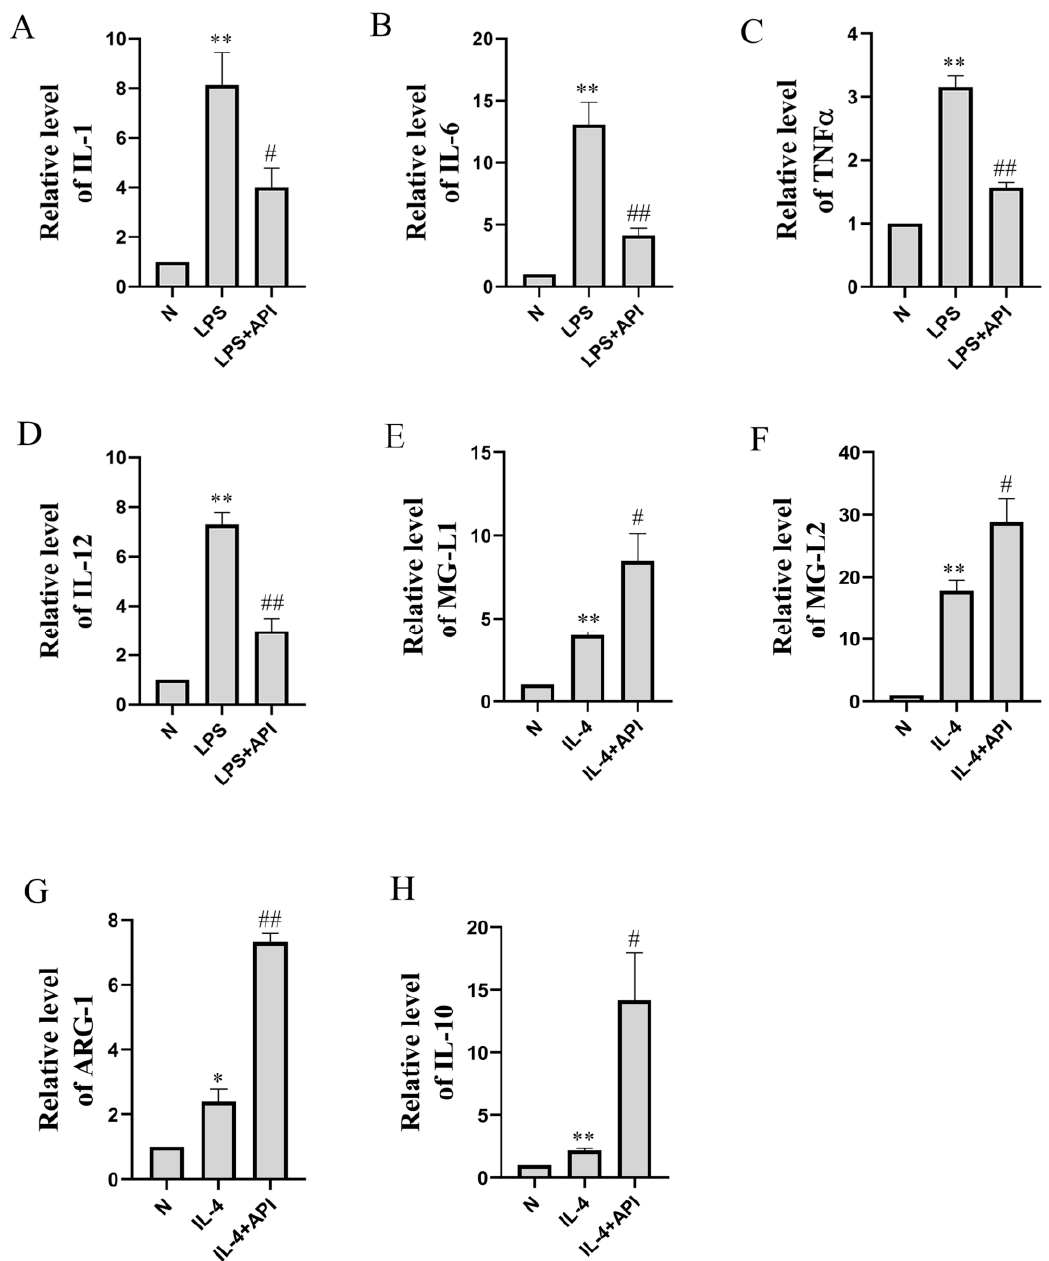
Figure 5. The effects of apigenin on the levels of inflammation-related mRNA of macrophages in the macrophage–chondrocyte coculture system. Relative quantities of inflammation-related genes are expressed as fold differences compared to the control. ( A ) IL-1, ( B ) IL-6, ( C ) TNF- α , ( D ) IL-12, ( E ) MG-L1, ( F ) MG-L2, ( G ) ARG-1, and ( H ) IL-10. Data are the mean ± SD of the mean ( n = 3). * p < 0.05 versus normal group (N); ** p < 0.01 versus normal group (N); # p < 0.05 versus LPS or IL-4 group; ## p < 0.01 versus LPS or IL-4 group.